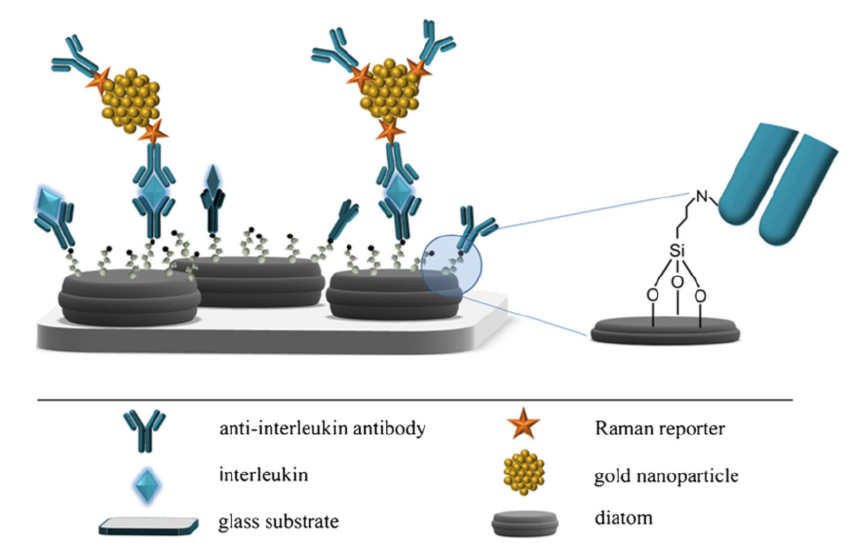
Figure 5. Schematic representation of the SERS immunoassay described in Ref. [79], with indication of the single elements of the sandwich structure. Antibody immobilization, interleukin capture and a detail of the link between the frustule and the bioprobe through an amino group are also illustrated. Reproduced with